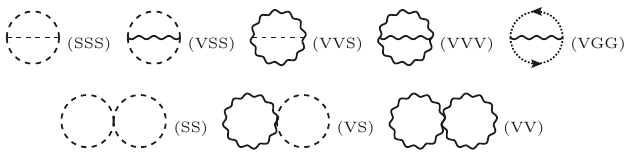
Figure 13 . Diagram topologies contributing to the two-loop effective potential. Dashed lines denote scalars (S), wavy lines denote vector bosons (V) and dotted lines refer to ghost fields